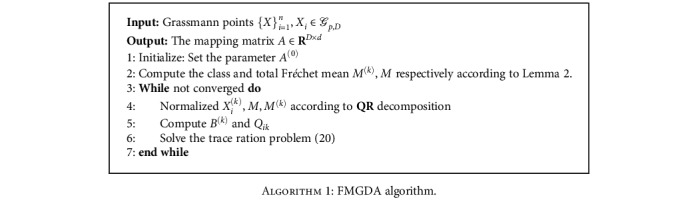
 FMGDA algorithm.